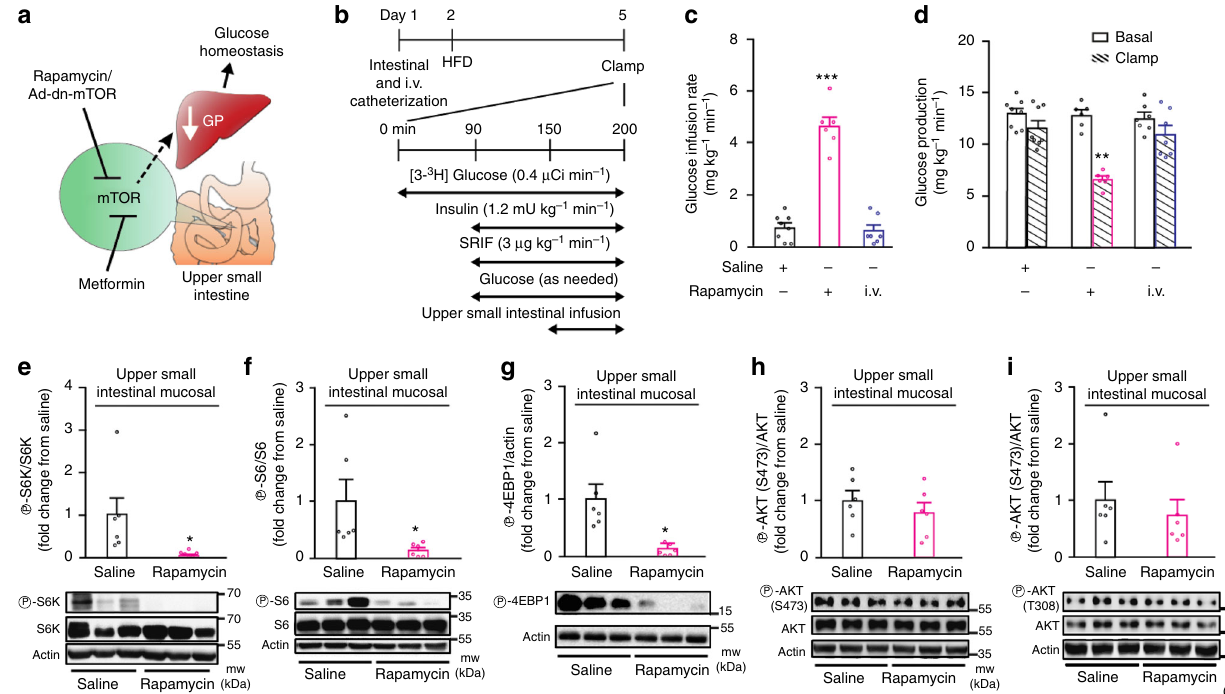
Fig. 1 Upper small intestinal rapamycin infusion lowers glucose production and inhibits mTOR signaling. a Schematic representation of the working hypothesis. b Experimental procedure and pancreatic (basal insulin) – euglycemic clamp protocol. SRIF, somatostatin; µ Ci, microcurie. c , d The glucose infusion rate ( c ) and glucose production ( d ) during the clamp in HFD rats infused with upper small intestinal saline ( n = 8) or rapamycin ( n = 6) or with intravenous (i.v.) rapamycin ( n = 7). ** p < 0.01 or *** p < 0.001 vs. all other groups as determined by ANOVA with Tukey ’ s post hoc test. e – i Quantitative analysis and representative western blot of phosphorylated S6K ( e ), S6 ( f ), 4EBP1 ( g ), AKT (S473) ( h ), and AKT (T308) ( i ) protein expression in the upper small intestinal mucosa of HFD rats infused for 50 min with upper intestinal saline or rapamycin. The phosphorylation level was quanti fi ed by densitometry and data are presented as fold increase in rapamycin ( n = 6) over the saline ( n = 6) treated samples. Actin, loading control. * p < 0.05 vs. saline as calculated by unpaired t -test. Values are shown as mean ±